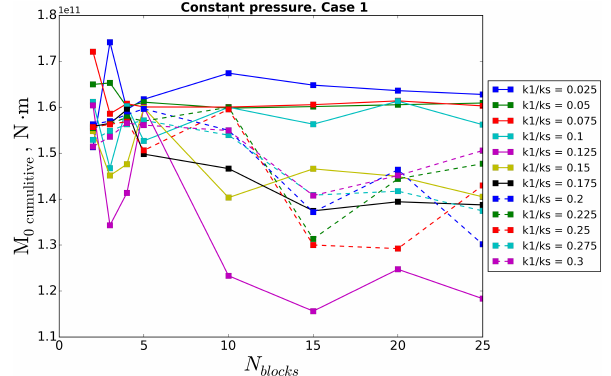
Figure 11. Maximum seismic moment vs. number of blocks.